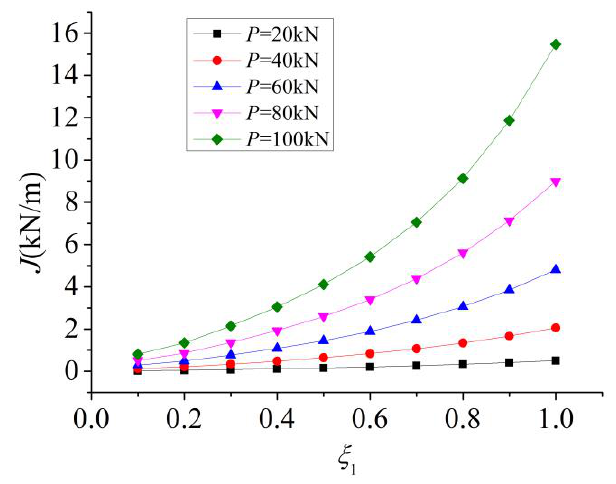
J  − curves for different eccentric compression. Figure 19. J − ξ Figure 19. 1 curves for different eccentric compression. 1 The calculated values of the J-integral are extracted when the load is P = 100 kN.